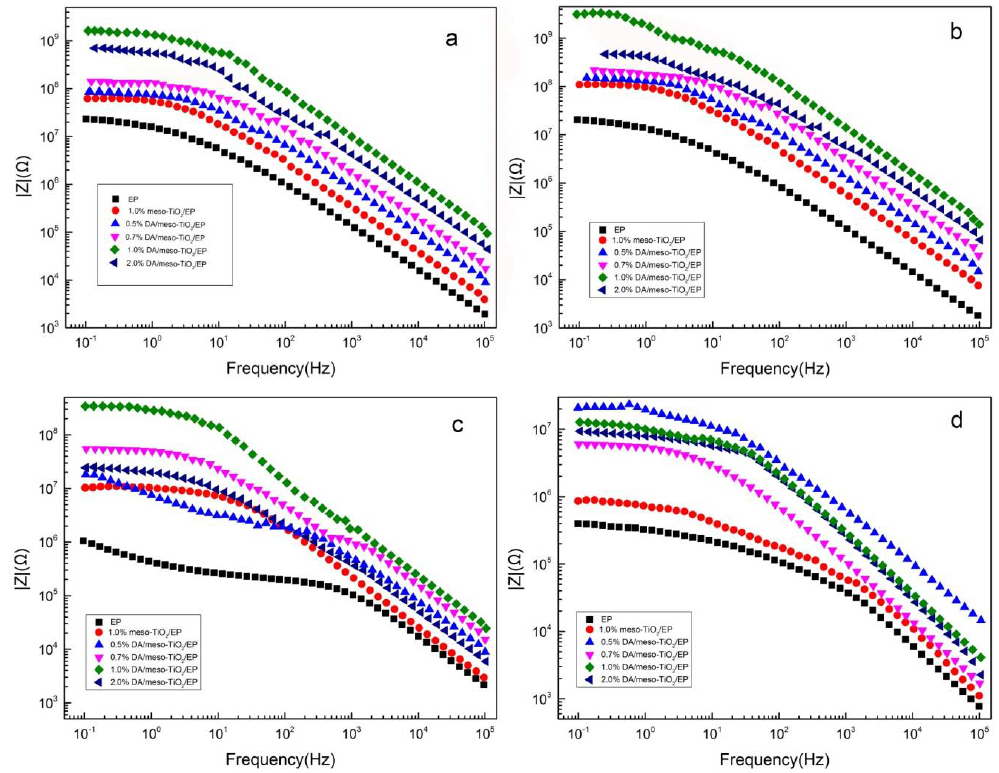
Figure 9. Bode magnitude plots of the samples immersed in 3.5% NaCl solution for various times: